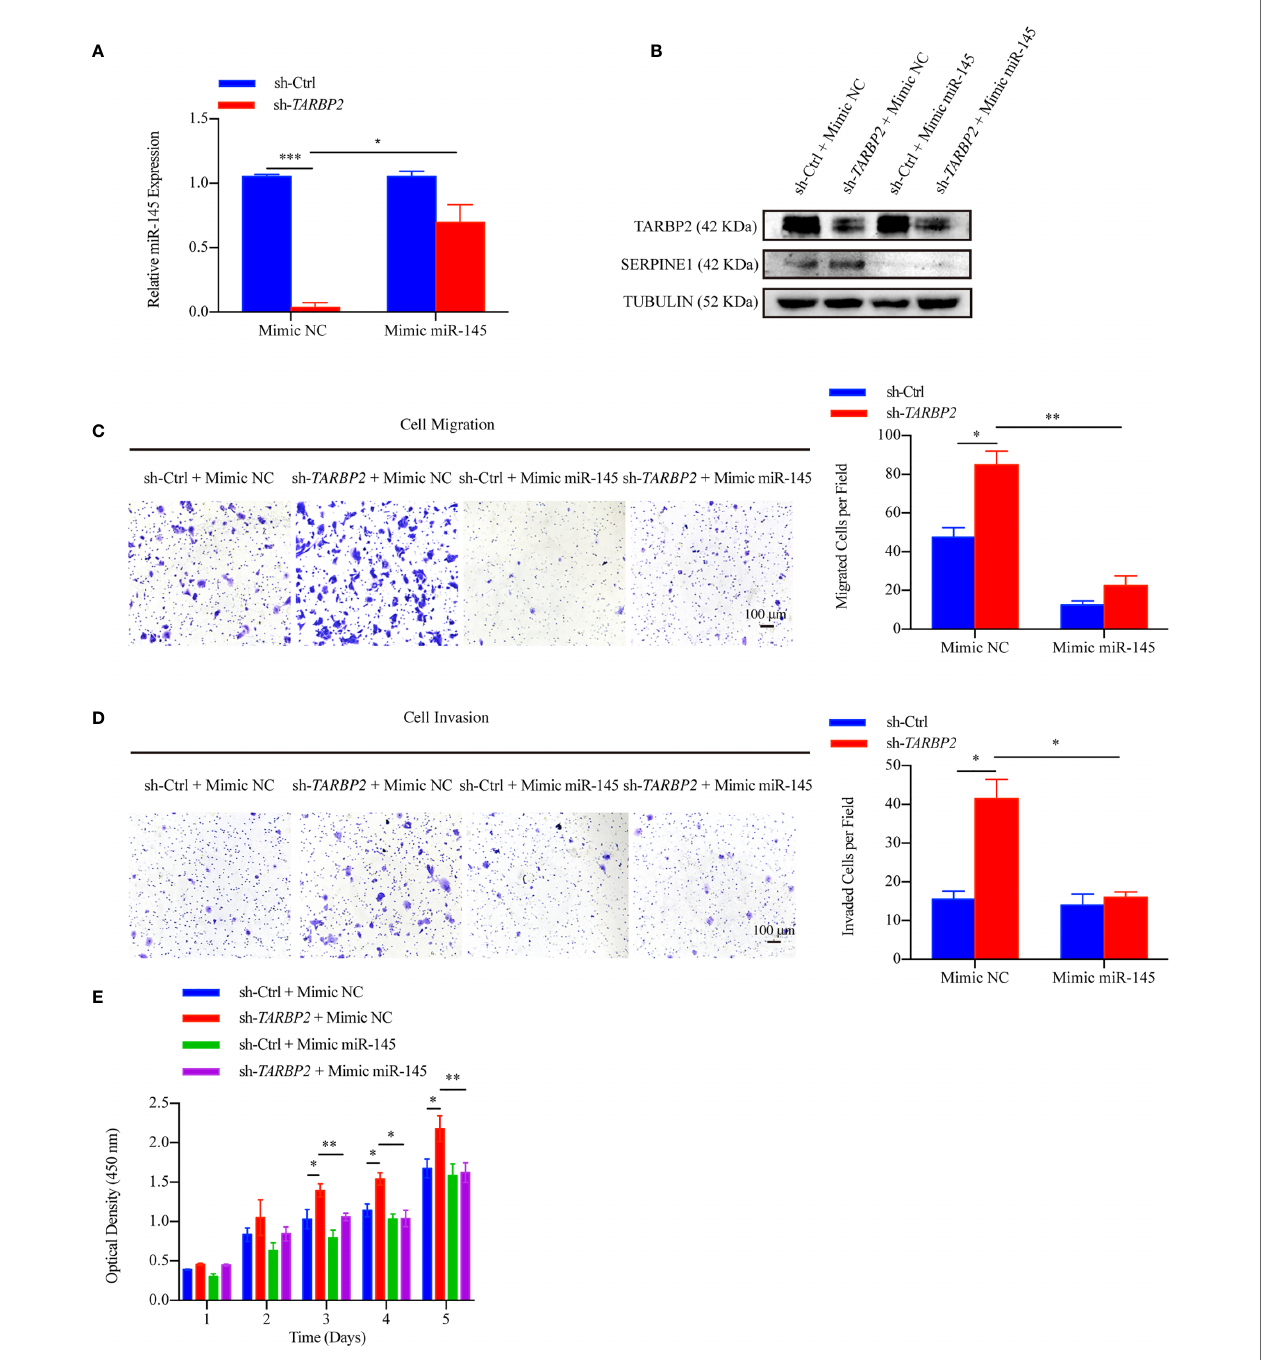
FIGURE 7 | miR-145 mediates SERPINE1 to affect the role of TARBP2 in HCC progression. (A) Levels of miR-145 in sh-TARBP2 HepG2 cells after treatment with Mimic NC and Mimic miR-145. (B) Protein levels of SERPINE1 and TARBP2 in the stable sh-TARBP2 HepG2 cells after treatment with Mimic NC and Mimic miR- 145. (C) Cell migration; (D) Invasion; and (E) Proliferation of sh-TARBP2 HepG2 cells treated with Mimic NC and Mimic miR-145. *p-value < 0.05; **p-value < 0.01; NC, negative